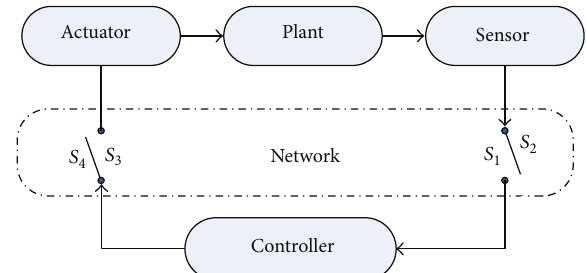
Figure 2: Four-state discrete event